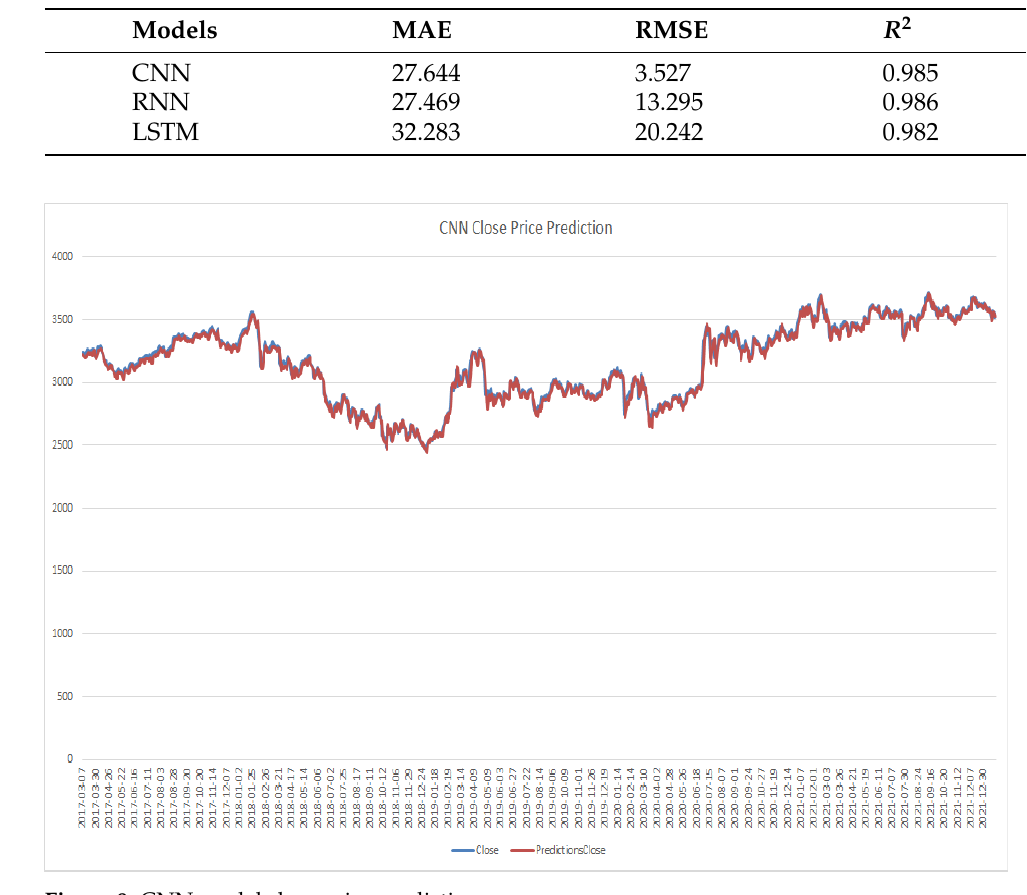
Table 4. CNN-LSTM-RNN Model Results.